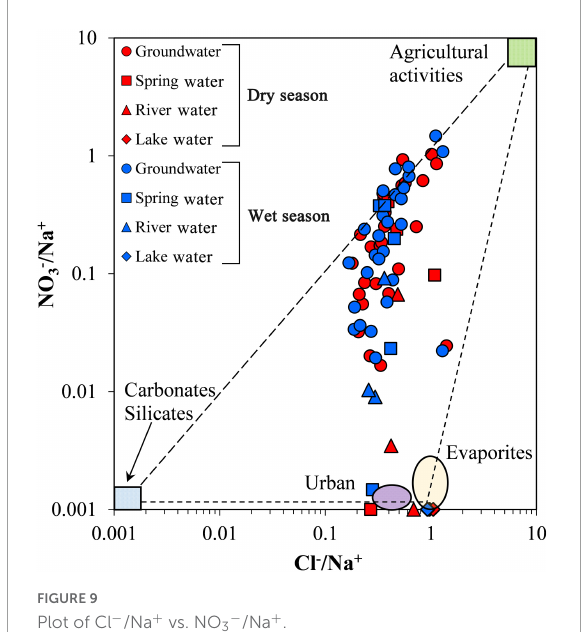
FIGURE9 Plot of Cl − /Na + vs. NO 3 − /Na +